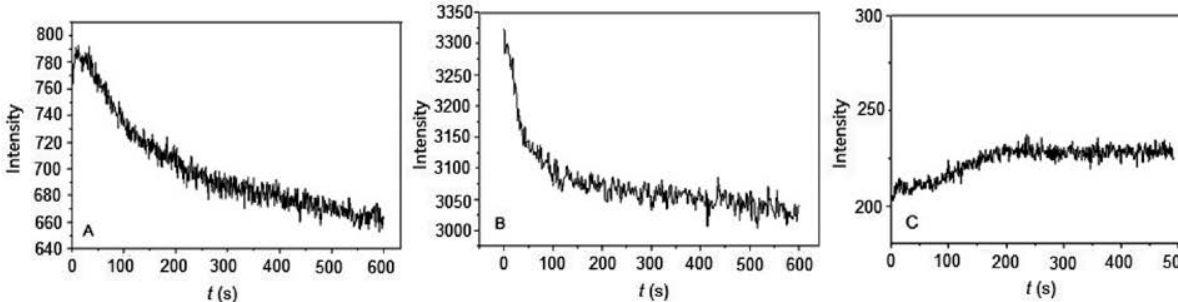
Fig. 4. Fluorescence intensity changes vs. time after adding (A) Pb 2+ , (B) Ag + , and (C) Hg 2+ .